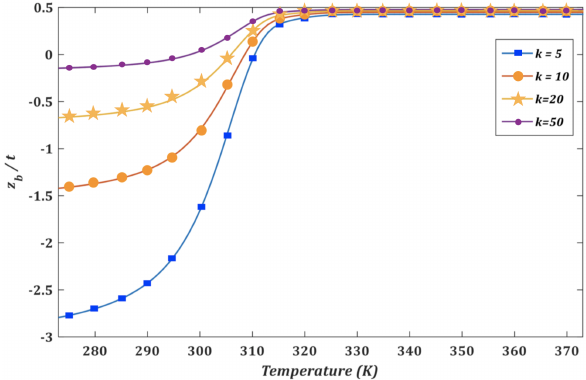
Figure 11: Variation of the position of the critical buckling surface z b / t with respect to temperature for various degree of bending, k ( m −1